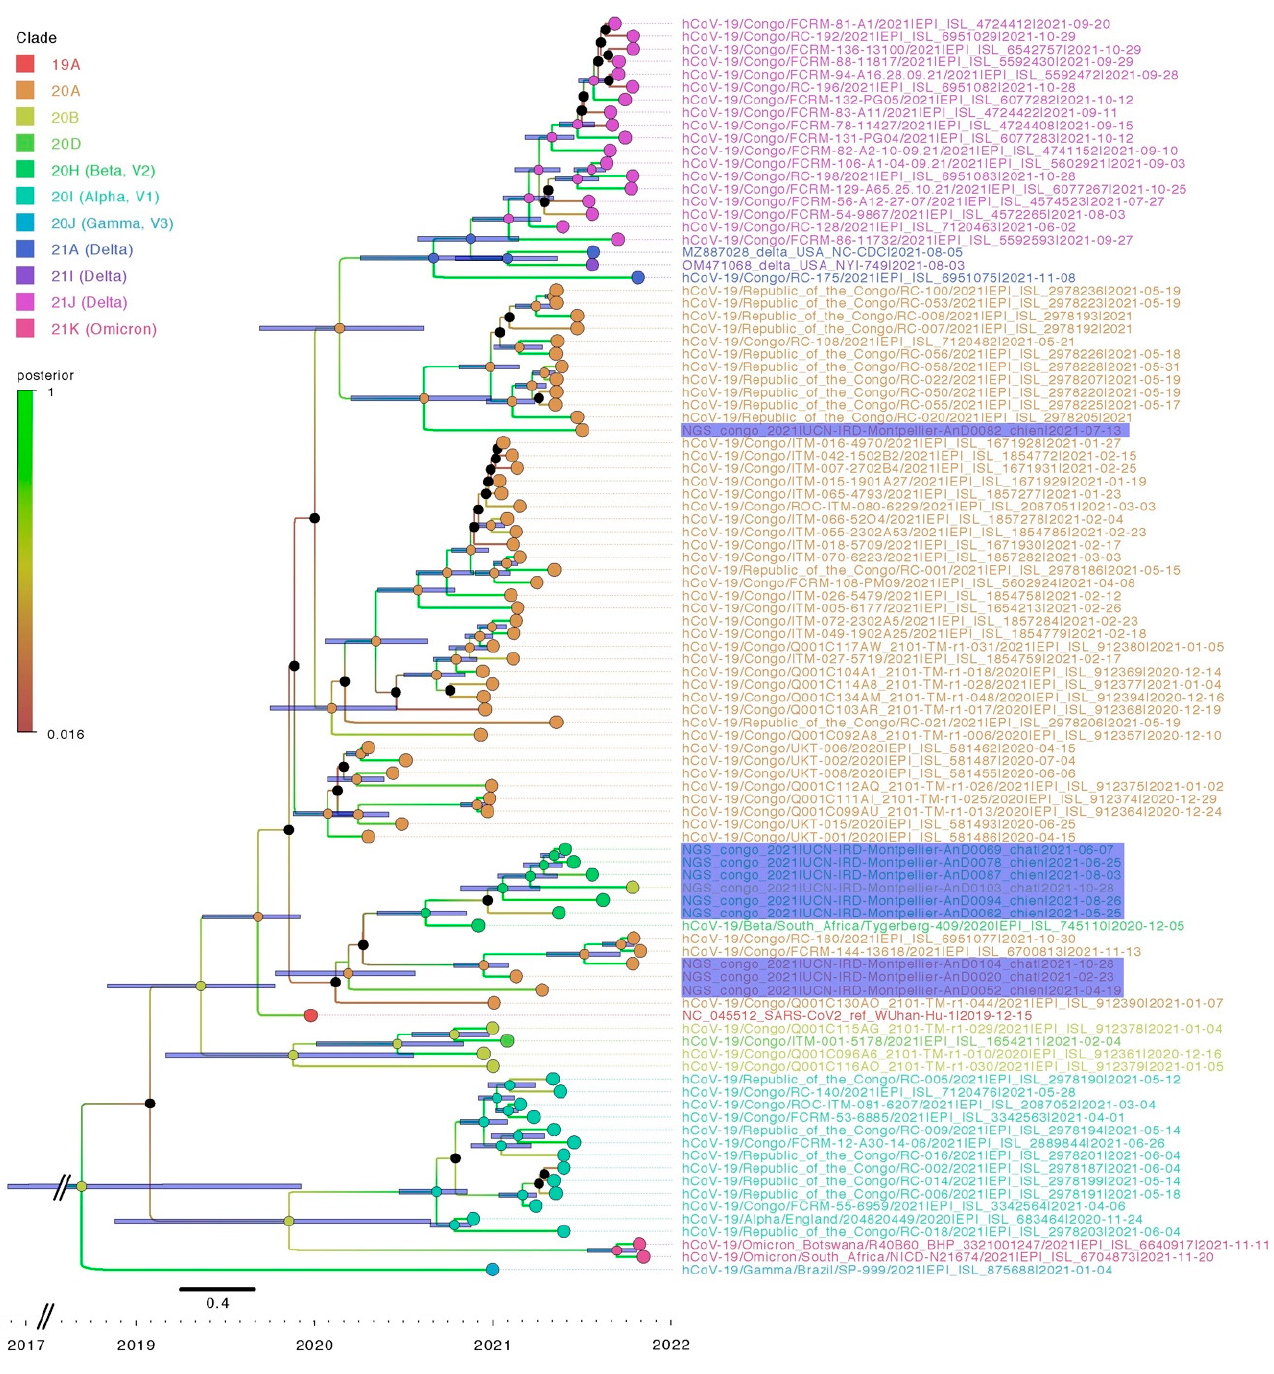
Figure 4. Bayesian phylogenetic analysis of ten pets’ SARS-CoV-2 whole genome sequences. The tree included eighty SARS-CoV-2 sequences from Congolese people and the reference sequences of alpha, beta, delta, and omicron VOCs available on GISAID. Pet sequences are highlighted in violet. Lastly, the lineage assignment of the SARS-CoV-2 genome sequence obtained from Cat-103 proved anomalous. Nextclade analysis classified it in clade 20B (B1533 lineage), while Bayesian phylogenetic analysis positions it in clade 20H (V2, B.1351, Beta variant) (Figure 4). A sliding window analysis (comparing the identity of the Cat-103